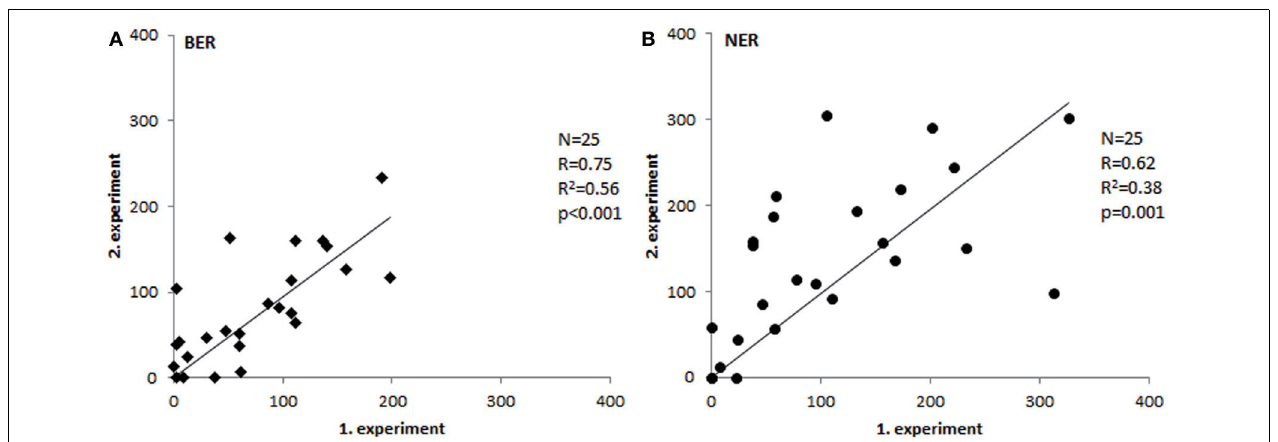
positive control with specific enzyme (PC). The experimental layout with 9 microscope slides is applicable only if the same substrate cell-type is used in each assay, so that the same non-treated cells can be used for both.